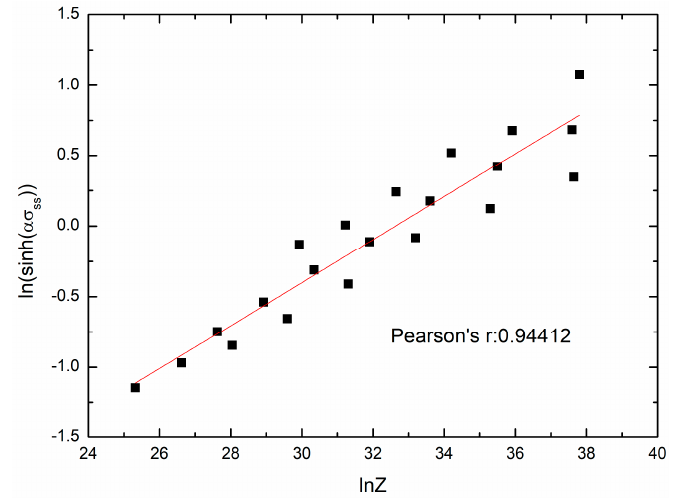
ασ and ln Z . ss ασ and ln Z . Figure 10. ss